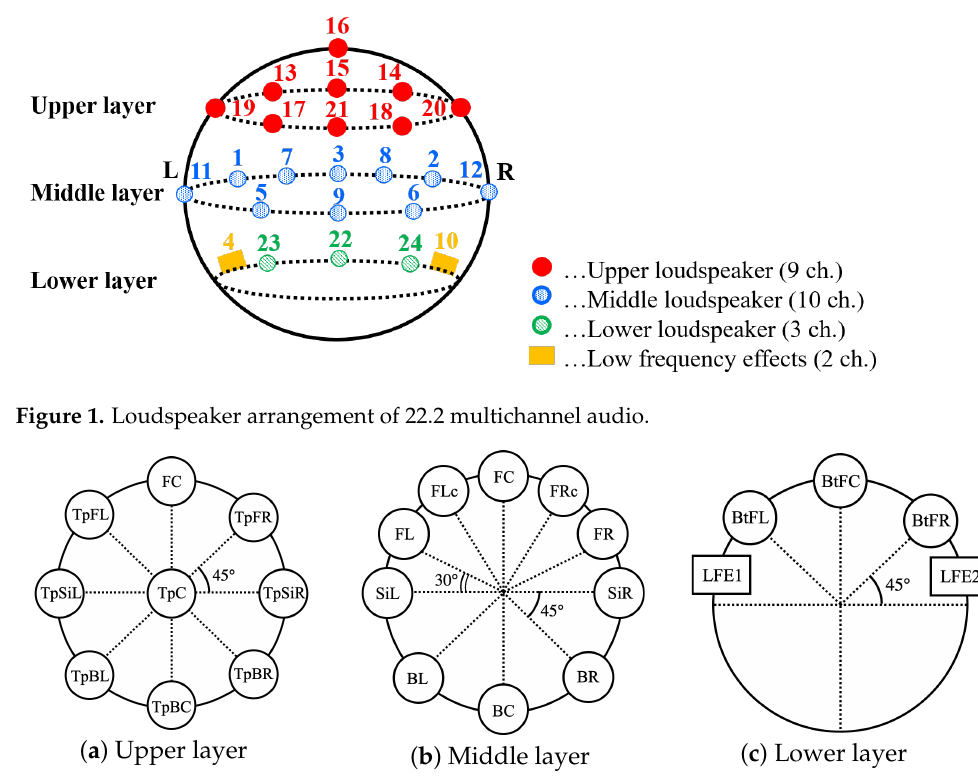
Figure 2. Labels and installation intervals of